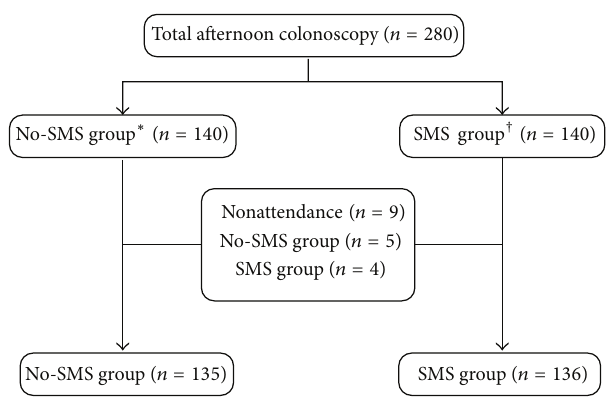
Figure 1: Flow of patients through the study. In the No-SMS group ∗ , patients took thefirst2L of PEG solution between 6 and 8PM on the day before colonoscopy and the second 2L of PEG approximately 6 hours before the colonoscopy with no SMS reminder. In the SMS group † , patients took first 2L of PEG in the same manner as the No- SMS group and the second dose of PEG 2L after receiving an SMS 6 hours before an afternoon colonoscopy. PEG, polyethylene glycol; SMS, short message service of cellular